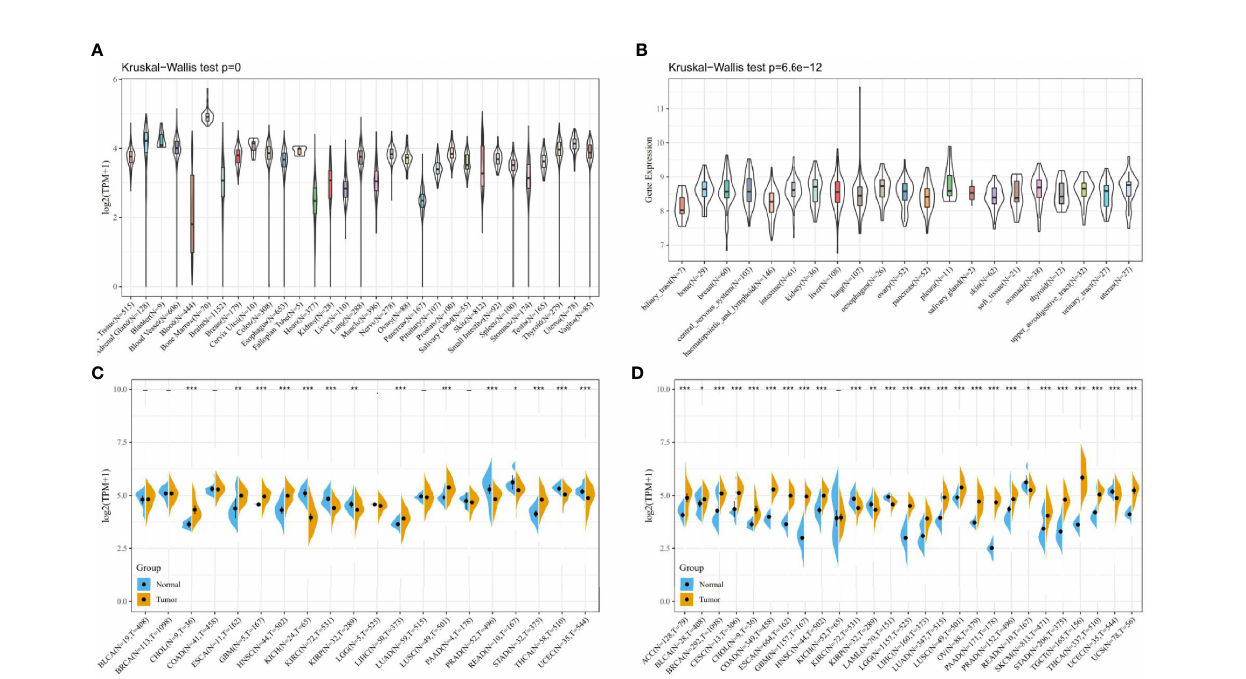
FIGURE 1 | ATG5 expression in pan-cancer. (A) Expression levels of ATG5 in a dataset containing 31 tissues, derived from the GTEx. (B) Expression levels of ATG5 in a dataset containing 21 tissue in tumor cell lines, derived from the CCLE. (C) Expression levels of ATG5 in tumor and paired adjacent noncancerous tissues containing 20 tissues from TCGA, *P < 0.05, **P < 0.01, ***P < 0.001. (D) ATG5 expression difference in 27 tumors integrating data of normal tissues in GTEx database and data of TCGA tumor tissues, *P < 0.05, **P < 0.01, ***P <